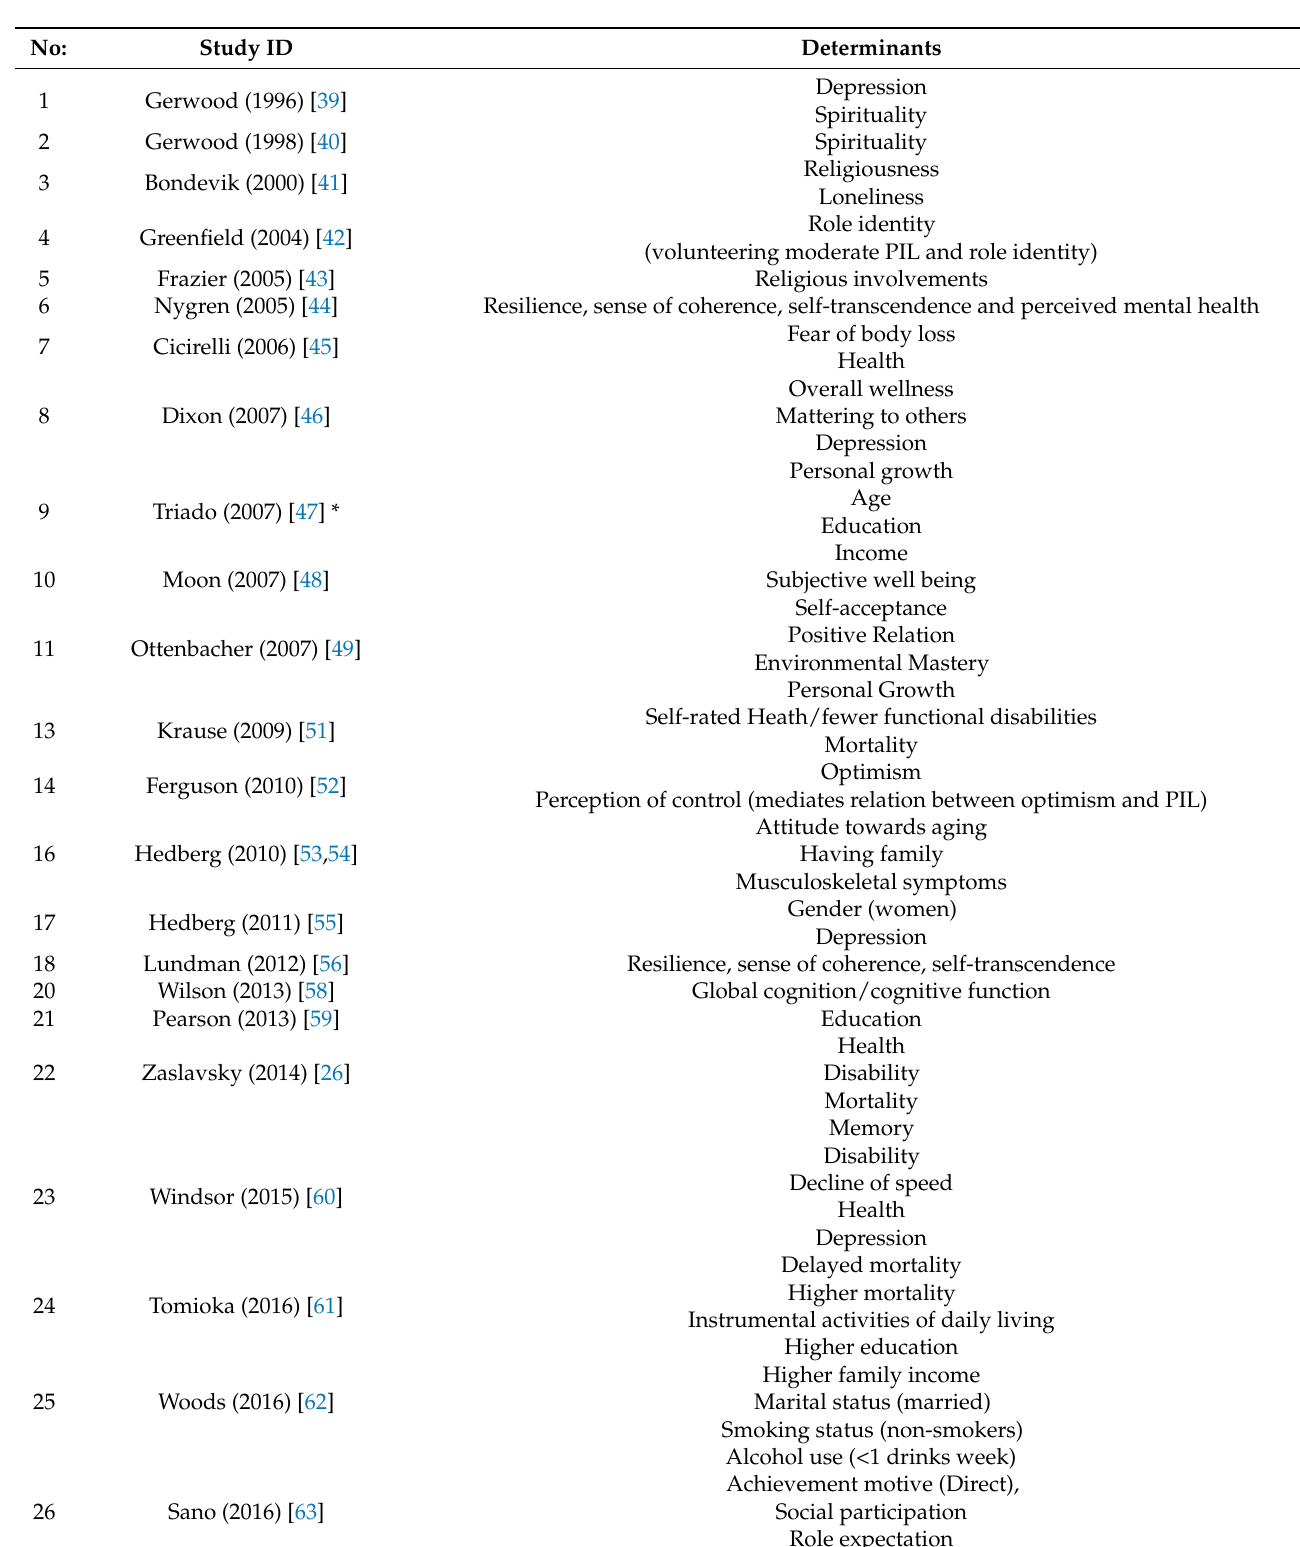
Table 3. Determinants of